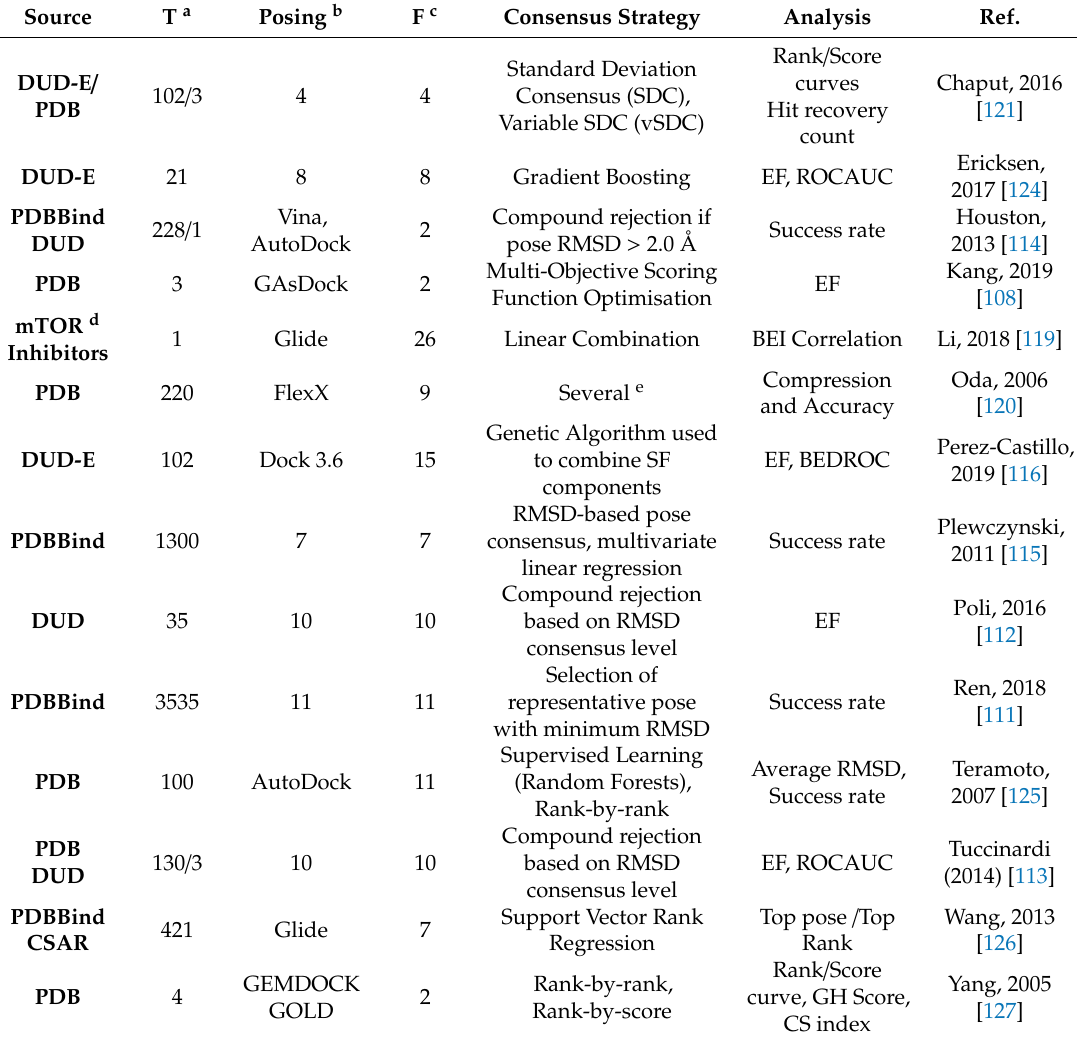
Table 2. Consensus docking methods.